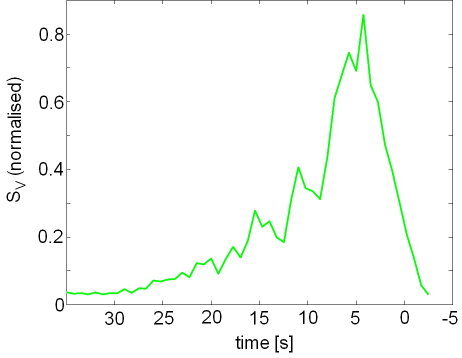
(cid:15) 2 xy d 3 x for a V